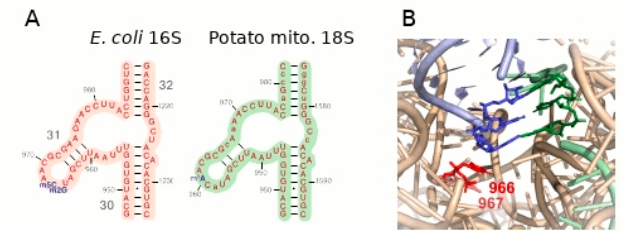
Figure 3. Methylation of the 18S rRNA. RNA-seq data revealed in about half of the reads an A-to-T mismatch at position 960 of 18S rRNA (position 968 in domain 31 of E. coli 16S rRNA). Such mismatch is diagnostic of mis-incorporation during cDNA synthesis because of m 1 A methylation. ( A ) Comparison of the corresponding domains of the E. coli 16S rRNA (which is methylated at positions 966 and 967, m 2 G and m 5 C respectively) and of the potato 18S rRNA. Sequence differences are in lower case. ( B ) In the 3D structure of the bacterial ribosome, these nucleotides are close to the anticodon of the tRNA at position P (dark blue nucleotides in the tRNA structure pairing with the mRNA), with base 966 stacking with the first anticodon nucleotide.